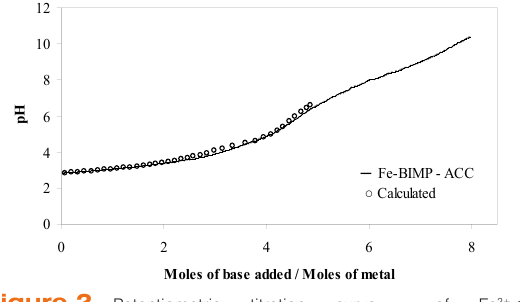
Figure 2. Potentiometric titration curve of Fe 2+ -1- aminocyclopropane carboxylic acid